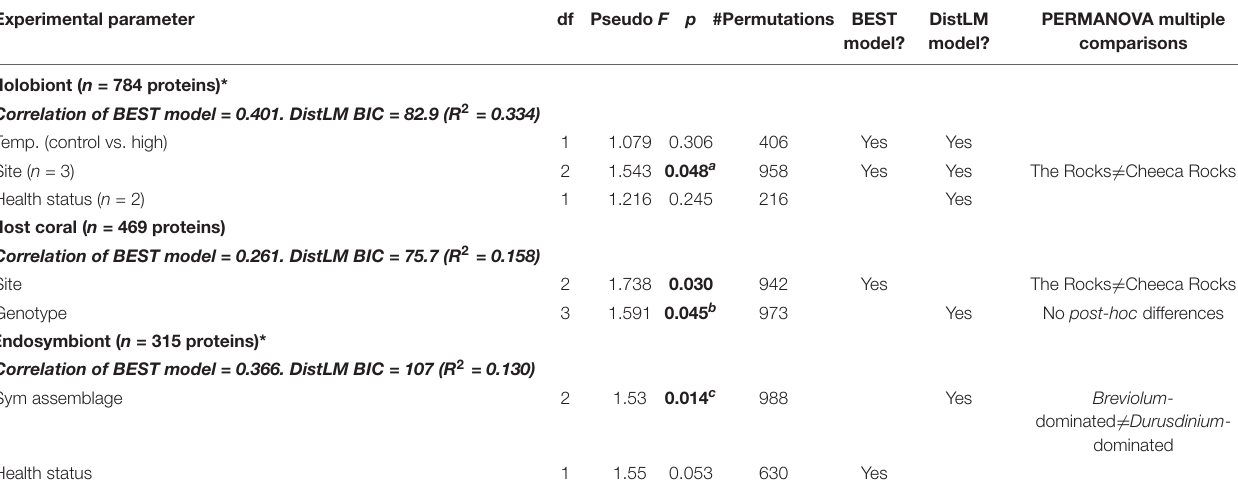
TABLE 2 | Statistically significant multivariate effects on the Orbicella faveolata -Symbiodiniaceae (Sym) proteome. Experimental